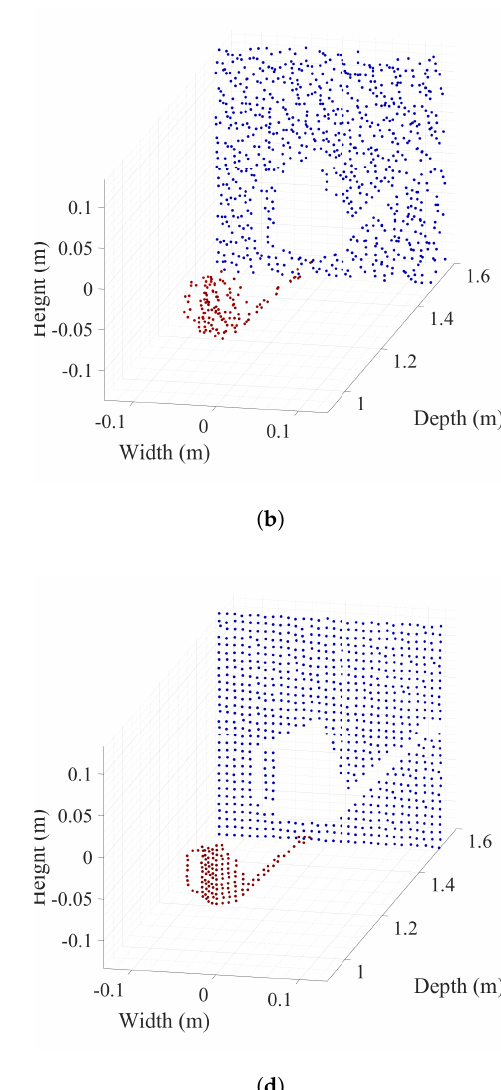
Figure 11. Experimental conditions for the sample object measurement.